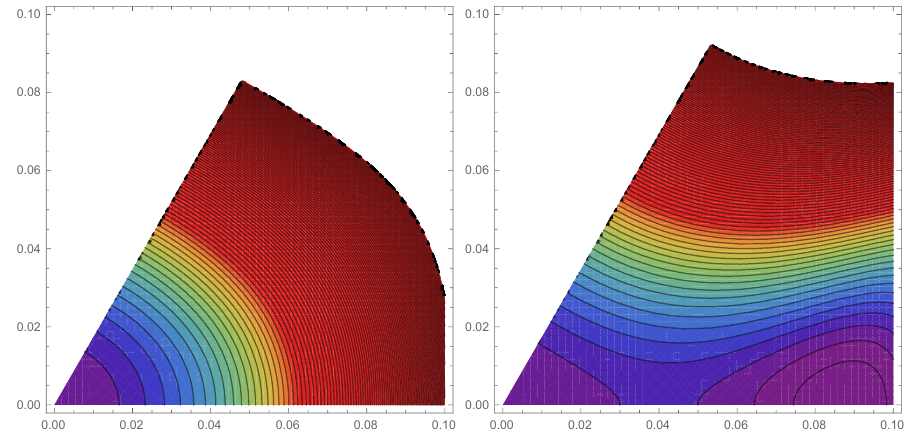
Figure 2. Output of the contour plot drawing subroutine for 128 Xe from the habs[] database and 180 Pt from the fort[] database. The plots are given as a function of ( β , γ )